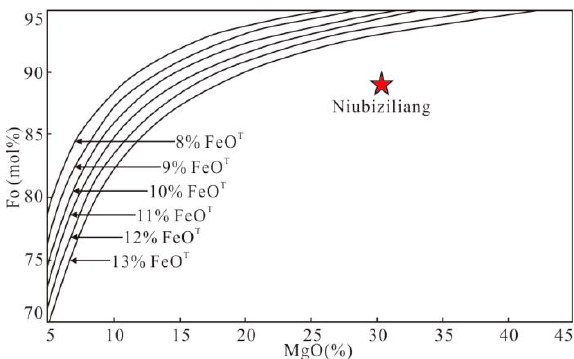
Figure 12. MgO-Fo-FeO diagram of harzburgite showing an excess of olivine adding to the magma in the Niubiziliang Ni-(Cu) deposit (modified after Zhang and Wang (2003) [37]). The MgO value in abscissa takes the mean value of MgO content in the whole-rock geochemistry of the corresponding sample and assumes the distribution coefficient of 0.3.